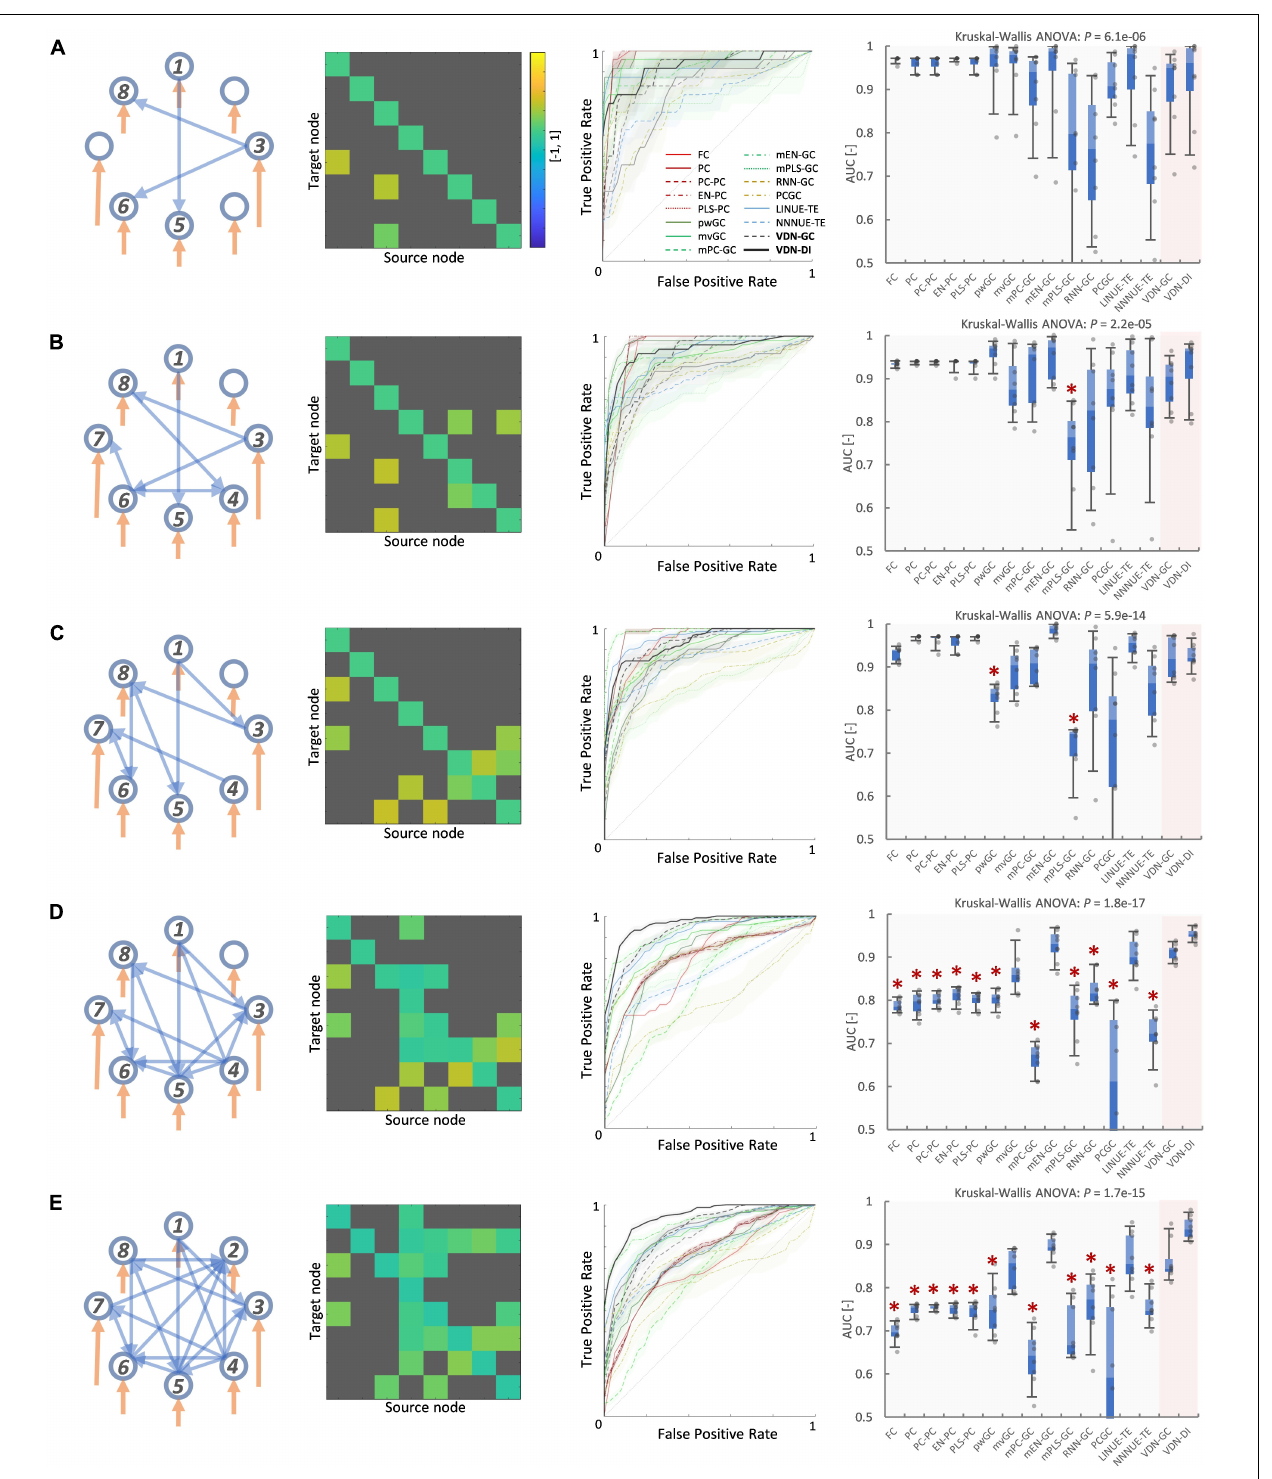
FIGURE 3 | (A) Sparse pattern of 8-node network of network density 0.2. Eight self-connections and three other connections. From left to right images show the ground truth network graph, the matrix A for the DCM, the ROC curve result of ground truth estimation by each analysis algorithms, and the box-plot of AUC results, respectively. The color bar describes the matrix A- values for (A–E) . In the box-plot, a black dot shows each experimental result and a red asterisk shows significant difference from VARDNN-DI to other algorithms by Steel test (* p < 0.05) ( N = 8). (B) Result of network density 0.25 (sparse pattern of 8-node network). (C) Result of network density 0.3. (D) Result of network density 0.41 (E) Result of network density